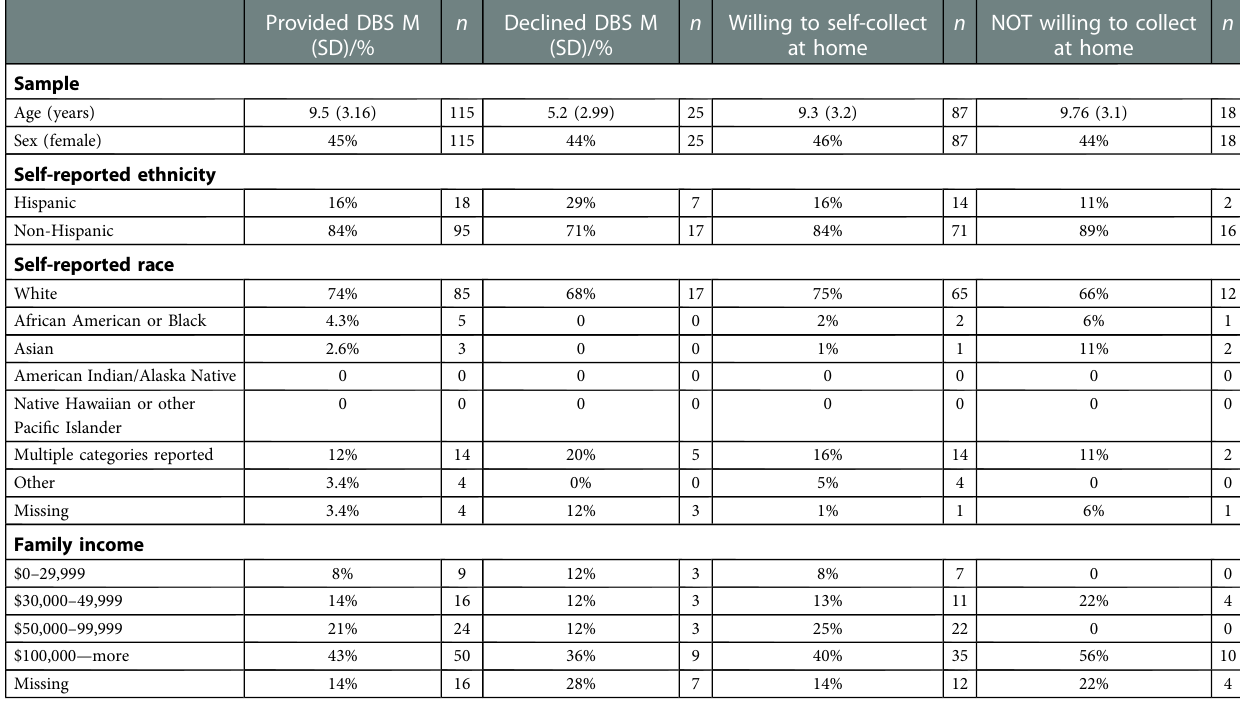
TABLE 1 Sample demographics by